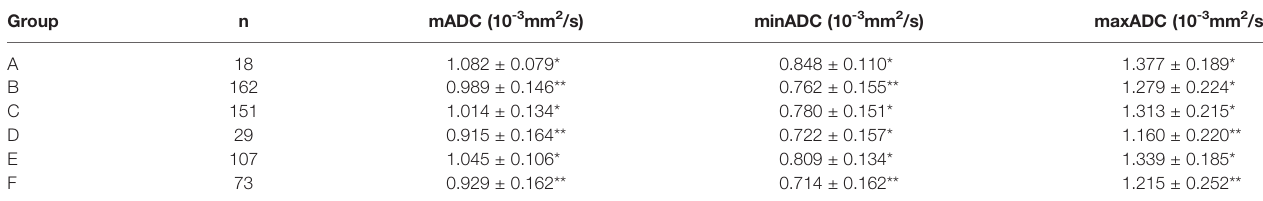
Different superscript symbols (*,**) indicate signi fi cant Differences between two groups (p < 0.05), either superscript symbols are same mean the difference is not signi fi cant (p >